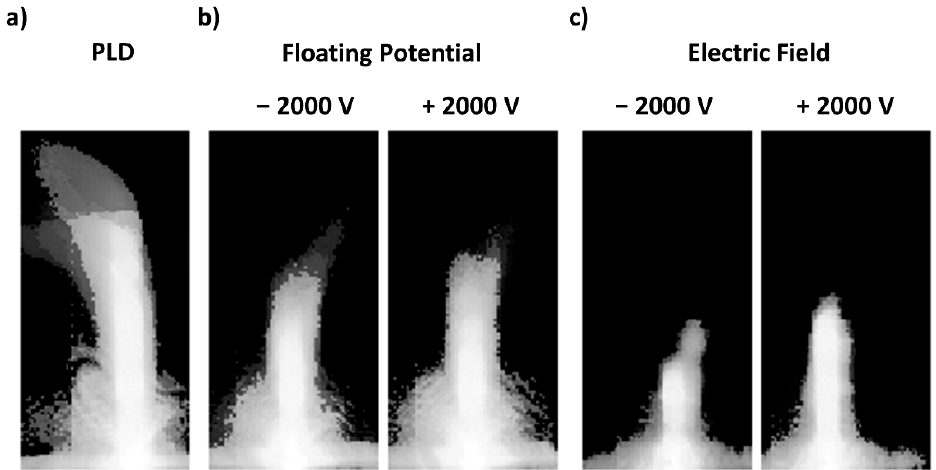
Figure 5. The superimposed images of nanoparticle plume of 236 frames extracted from the nanoparticle plume filmed during the process of laser machining in the parallel laser scanning direction under the ( a ) conventional PLD condition, ( b ) presence of a floating potential, and ( c ) presence of an applied electric field.